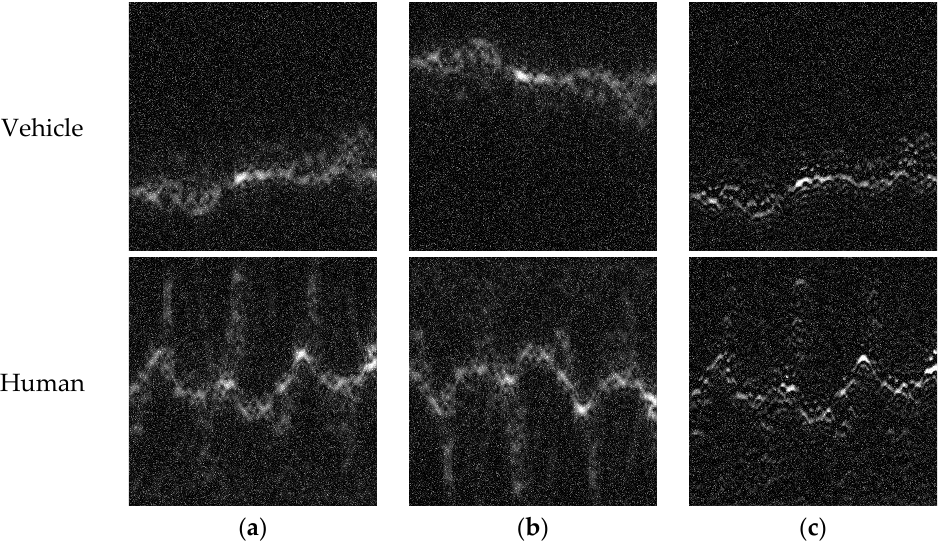
Figure 17. Generated samples obtained by the affine+sharpening method from the measured data. ( a ) The original image; ( b ) affine (reflex); ( c ) sharpening.